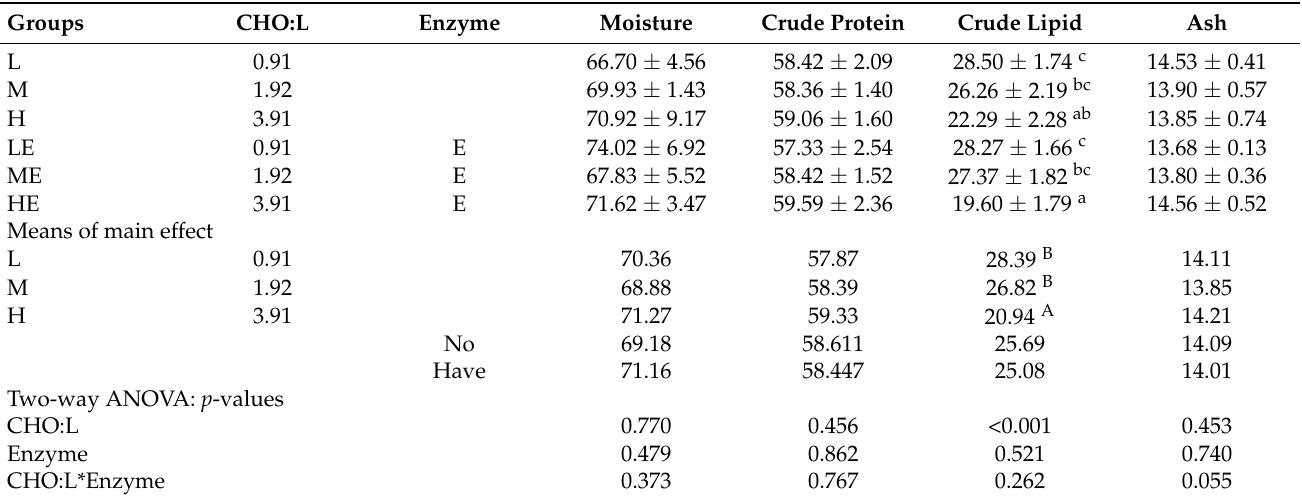
Table 4. Effects of carbohydrase supplementation on body composition in hybrid grouper fed different CHO:L ratios diets (n = 3).